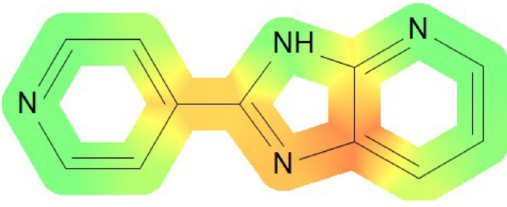
Figure 18. Ligand and in red genotoxic fragment.